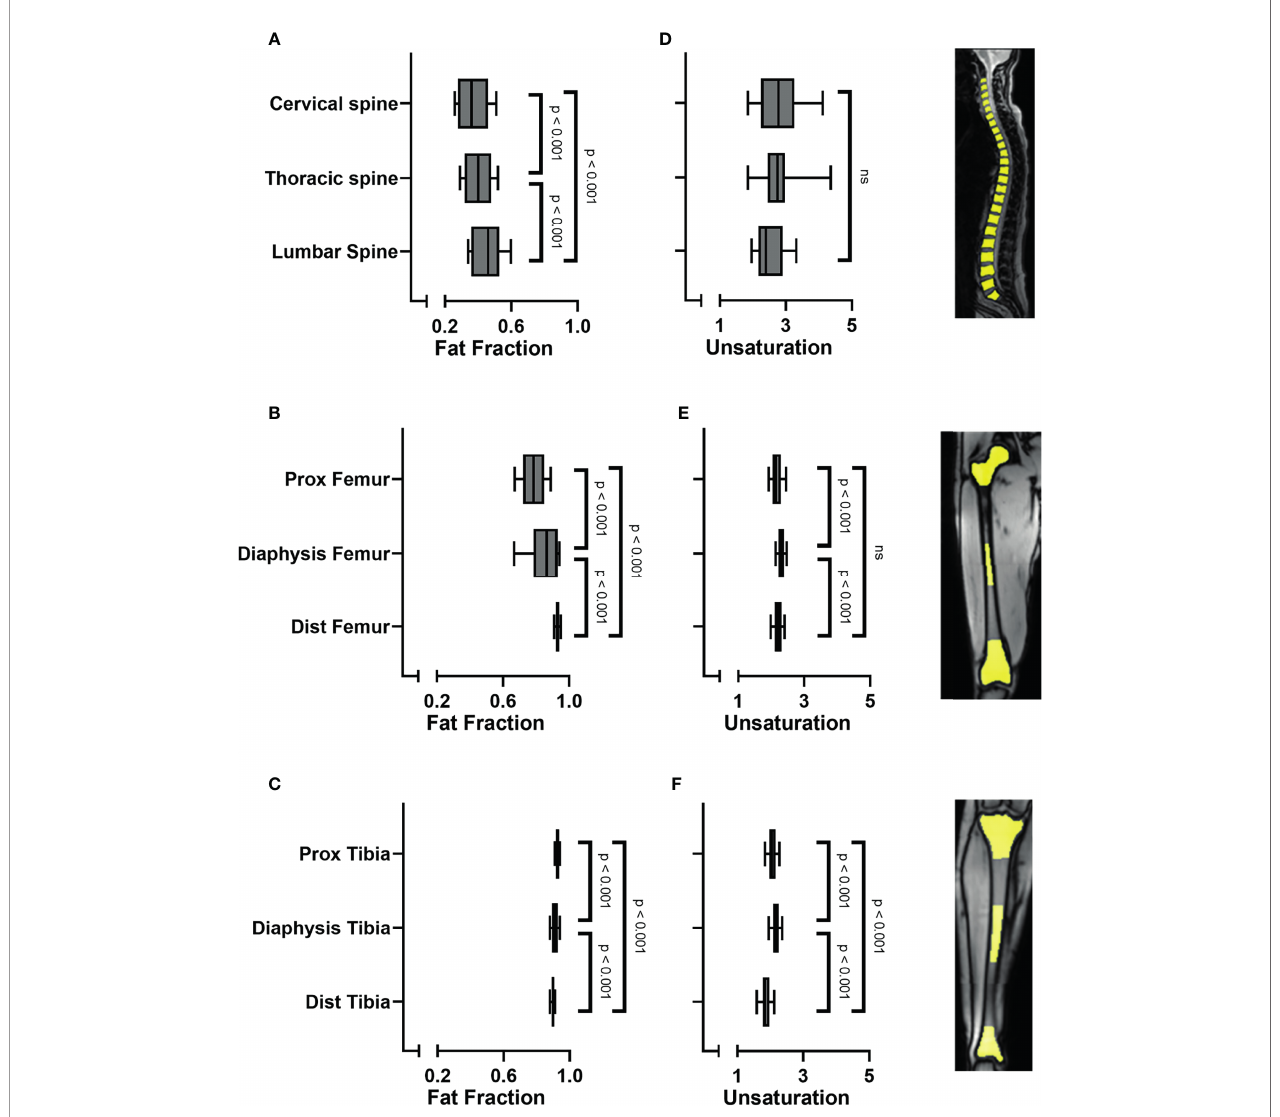
FIGURE 3 | (A) Bone marrow fat fraction increased from cranial to caudal within the spine (linear mixed model (LMM): p < 0.001). (B) Fat fraction increased in the femur from proximal to distal (LMM: p < 0.001). (C) Fat fraction decreased in the tibia from proximal to distal (LMM: p < 0.001). (D) Unsaturation (number of double bonds, ndb ) was similar when comparing the cervical spine, thoracic spine, and the lumbar spine (LMM: p = 0.09; ns). (E) Unsaturation was highest within the diaphysis of the femur (p < 0.001) and (F) within the diaphysis of the tibia (LMM: p < 0.001), compared to the proximal and distal sites. Images on the right side show representative images of ROI placement in the vertebral bodies of the spine, in the proximal epimetaphysis, the diaphysis and the distal epimetaphysis of the femora and tibiae. ns, non-signi fi